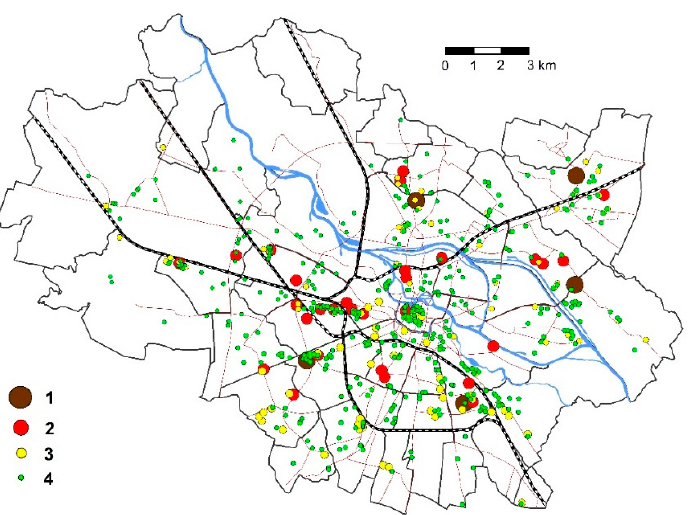
Figure 1. Distribution of industrial entities in Wroc ł aw in terms of the number of employees in 2016 (sourced by authors). Explanations: 1—industrial entity with 1000 and more employees; 2—industrial entity with 250–999 employees; 3—industrial entity with 50–249 employees; 4—industrial entity with 10–49 employees.